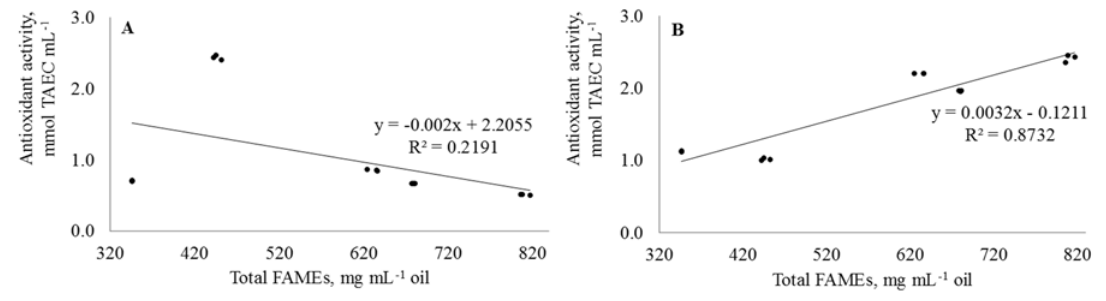
Figure 3. Correlation between total FAMEs (mg mL − 1 oil) and the antioxidant activities (mmol